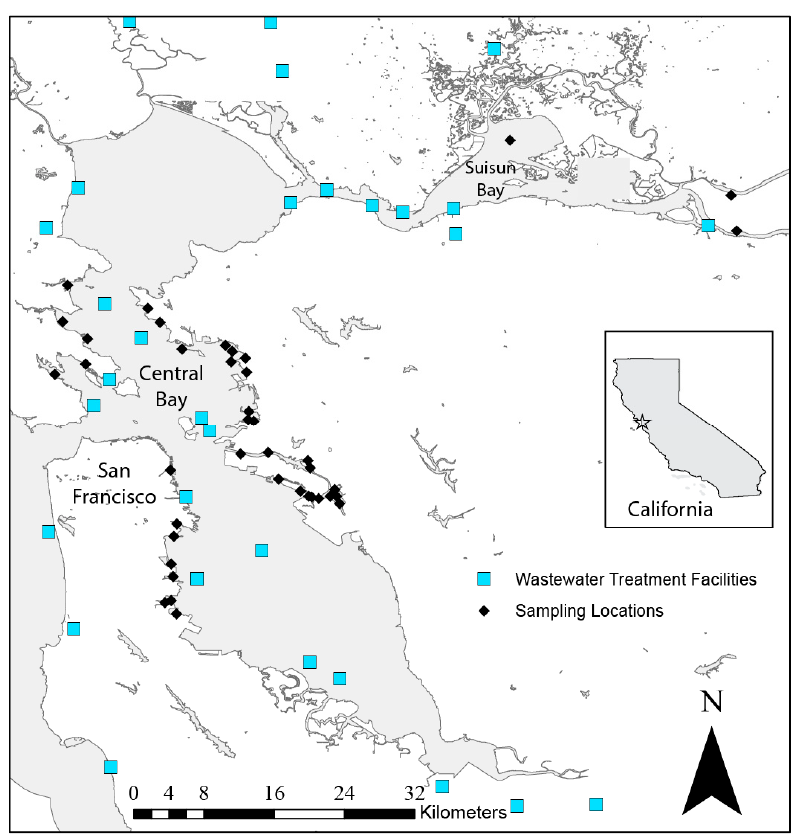
Figure 1. San Francisco Bay. Black diamonds ( ♦ ) indicate sediment collection location. Light blue squares ( █ ) indicate wastewater treatment discharge locations in the region. Inset: Location within California, USA. Table 1. Number of morphologically distinct bacterial colonies isolated from estuarine sediments in the San Francisco Bay Area, 2015, by antibiotic used for